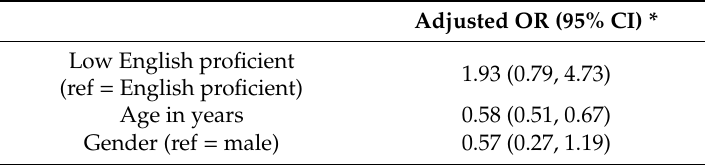
Table 4. Odds of no PACU pain score assessment, by English proficiency.